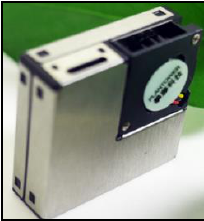
Figure 6. Air quality sensor (Model: PPMSA003 by Plantower, Image Source: Plantower)